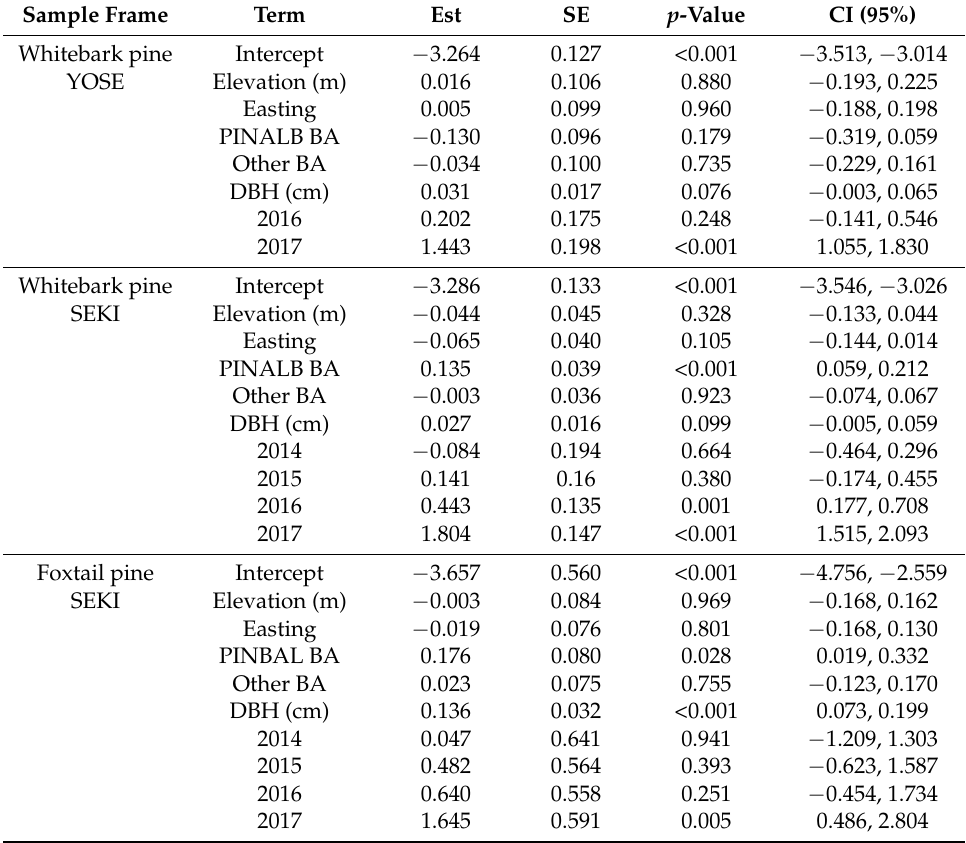
Table 2. Standardized regression estimates (Est), standard errors (SE), p -values, and 95% confidence intervals (CI) from the Generalized Linear Mixed Model of the proportion of average crown mortality for all sample frames. YOSE = Yosemite National Park, CA, USA. SEKI = Sequoia and Kings Canyon National Parks, CA, USA. BA = basal area (m 2 /ha), DBH = diameter at 1.37 m, Easting = UTM E,